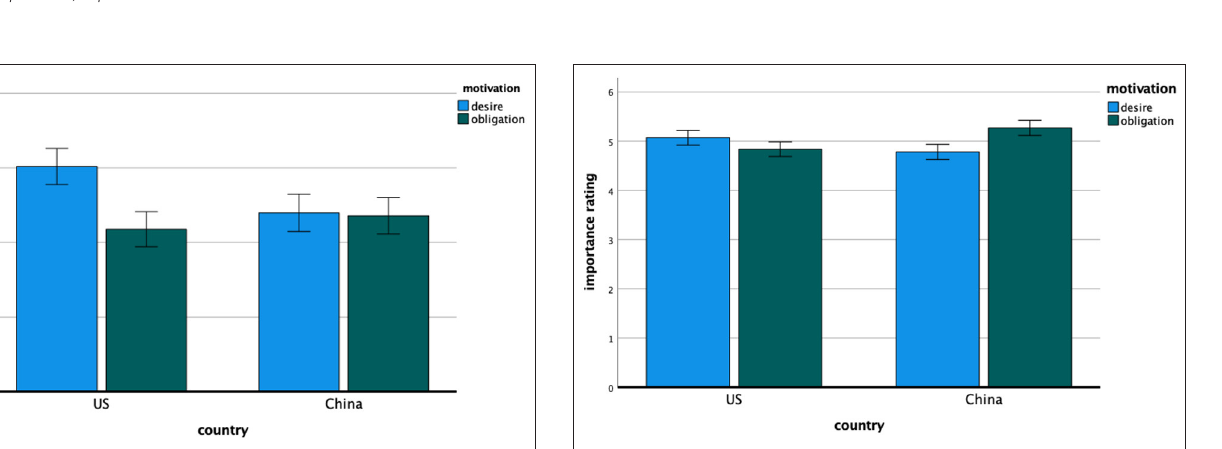
FIGURE 6 | Study 2—the importance rating of desire and obligation motivation for the self for American and Chinese participants. Error bars denote 95% confidence intervals of the